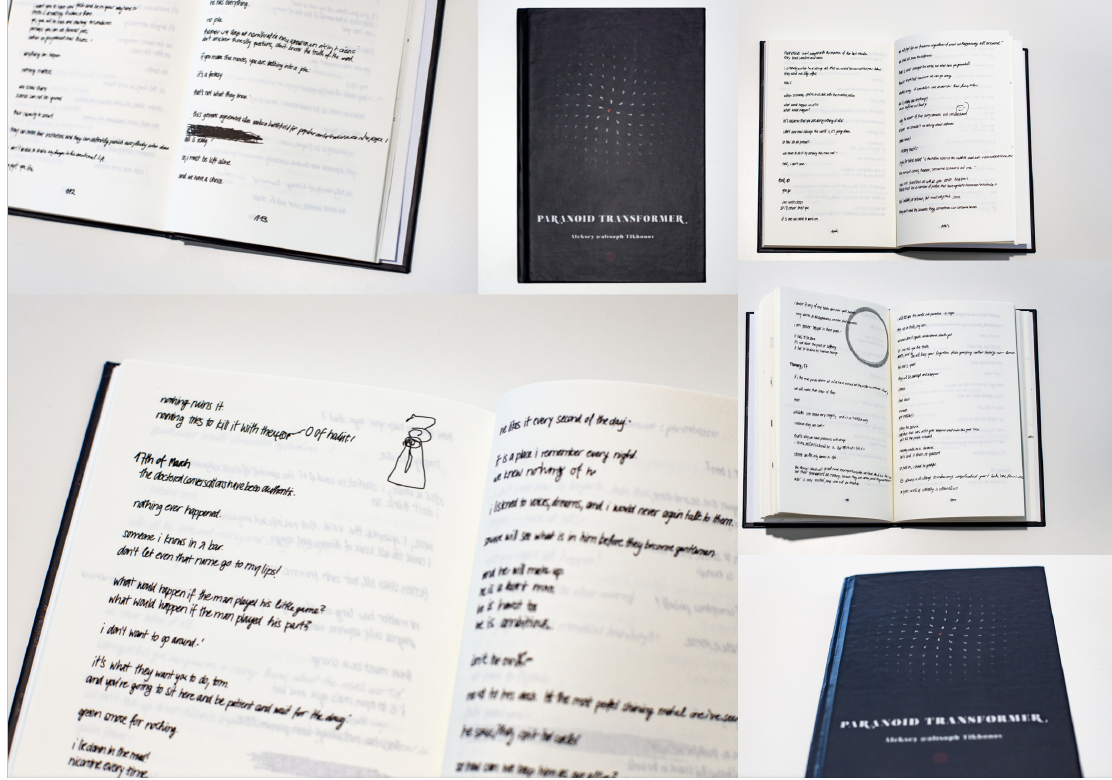
Figure 4. Hardcover version of the book by Paranoid